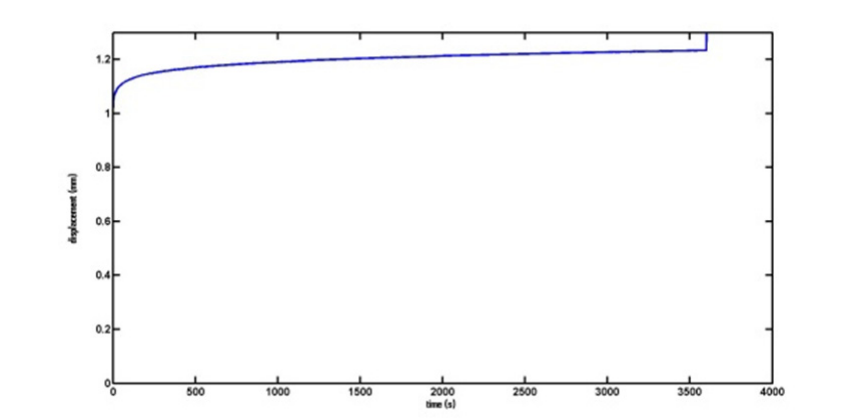
Fig. 3 Creep at 4000 N load